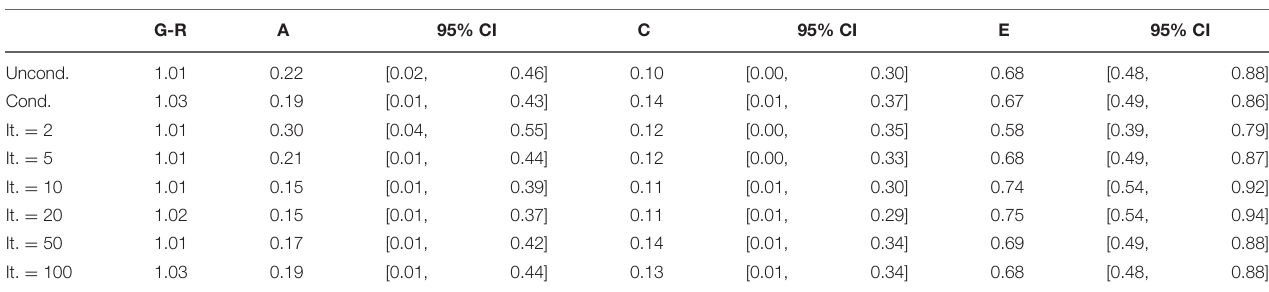
TABLE 10 | Univariate genetic analyses for payoffs in Monte Carlo simulations. G-R A 95% CI C 95% CI 95% CI